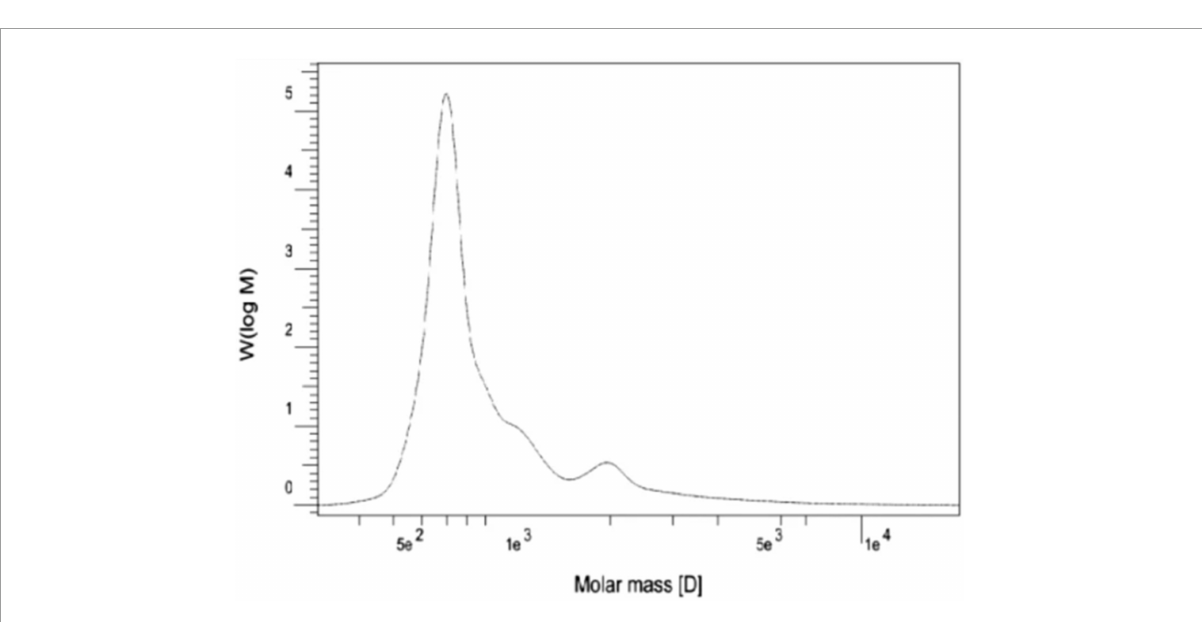
FIGURE11 Molecular weight distribution of E. macroclada extracted rubber by GPC.